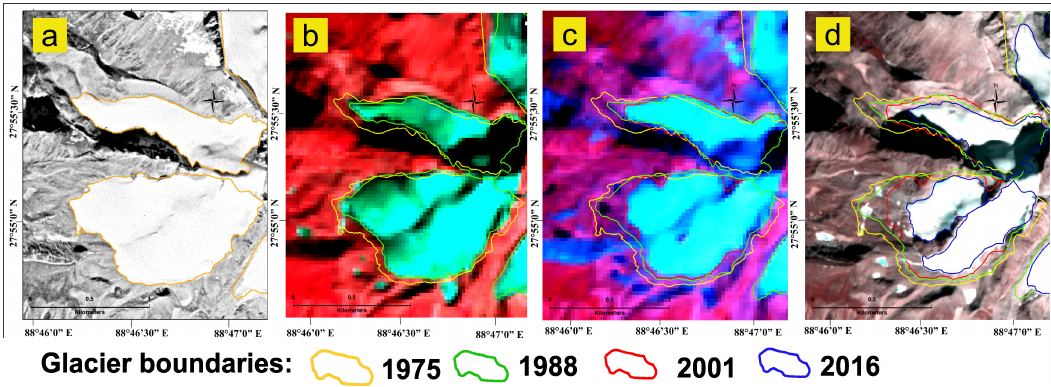
Figure 13. Fragmentation of a glacier into two. Different set of underlying images are: ( a ) Corona image (1975); ( b ) LANDSAT TM (1988); ( c ) LANDSAT ETM+ (2001); ( d ) Sentinel 2A (2016).